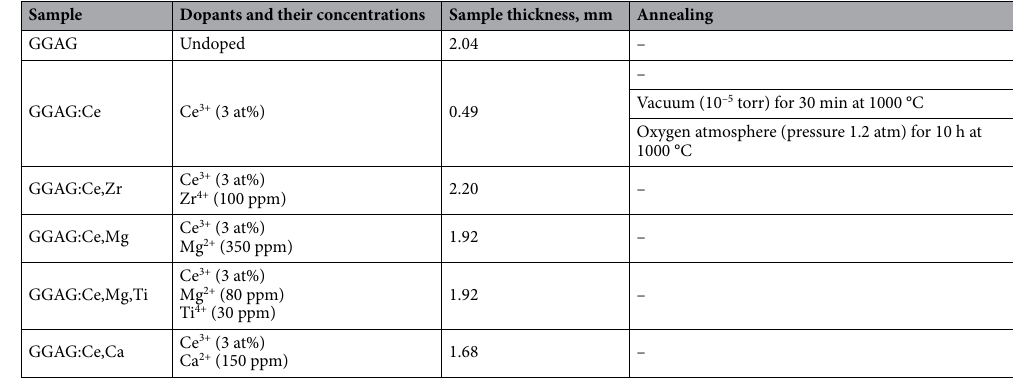
Table 1. The GGAG single crystals studied in current research.